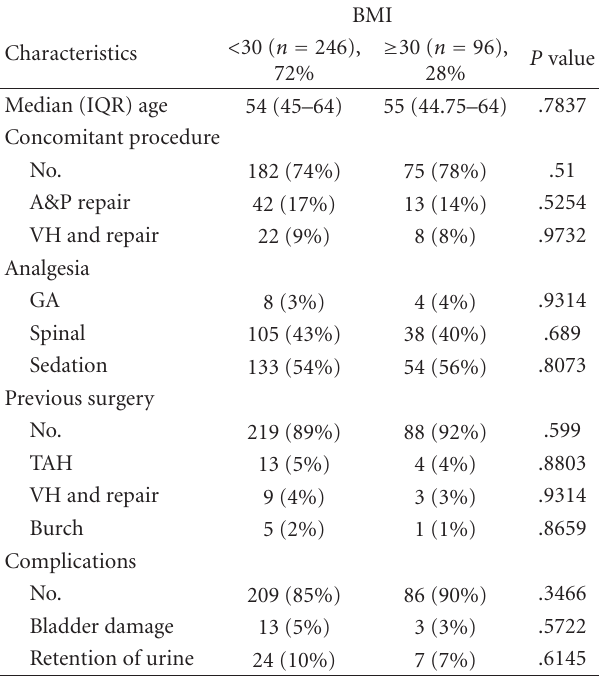
Table 1: Characteristic of cohort by body mass index